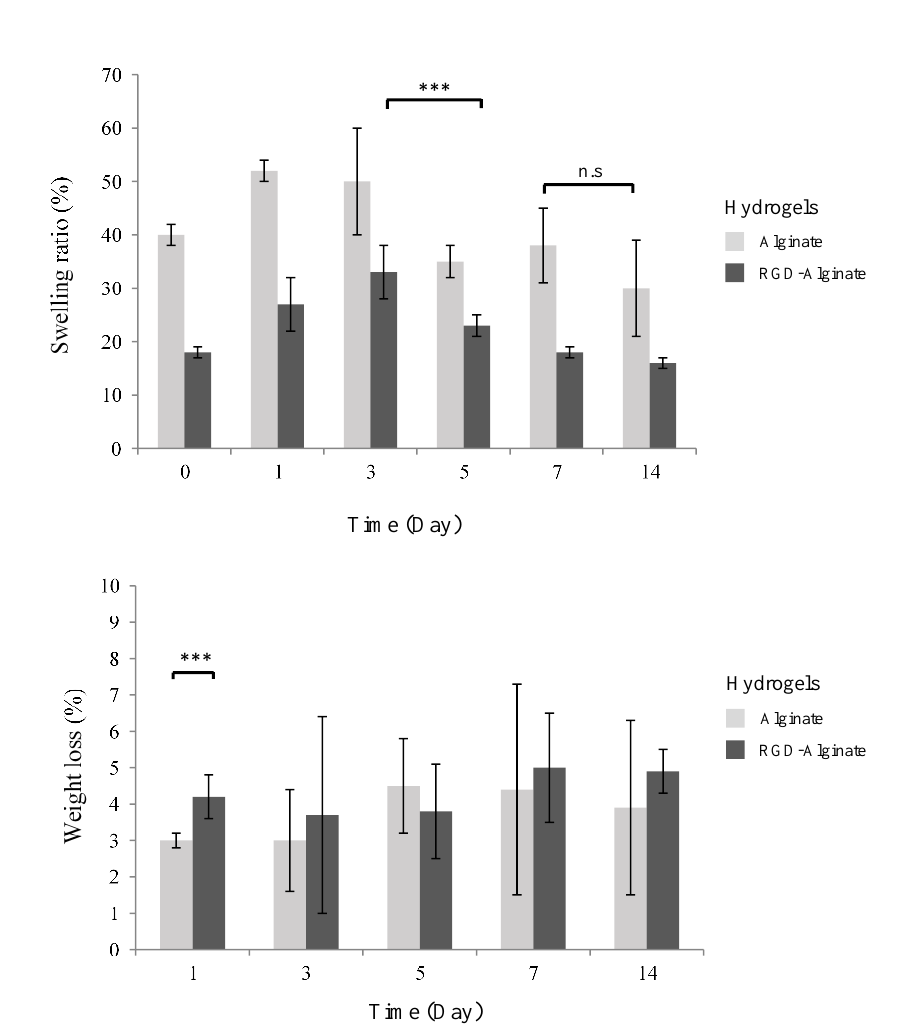
Figure 1. Physical properties of RGD-alginate hydrogel as compared to unmodified alginate hydrogel. ( a ) Swelling profile and ( b ) in vitro degradation profile. The hydrogels were incubated in PBS pH 7.4 at 37 ◦ C, removed from the incubation at different time points and data were measured ( n = 3). ANOVA test was used to determine significance; n.s = non-significant; *** = p < 0.001 was considered statistically significant.